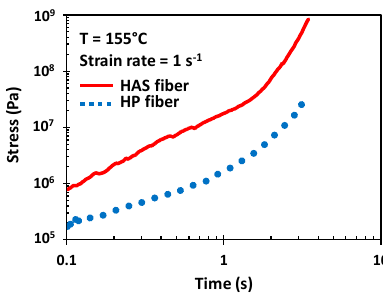
Figure 9. Tensile stress measurements of single HAS and HP microfibers at 1 s − 1 using the Meissner-type test. Shrinkage of the HAS microfiber was activated in the rheometer chamber immediately preceding the beginning of the test. The results show the average of five tests. Error bars have been omitted because the standard deviation was smaller than the magnitude of data